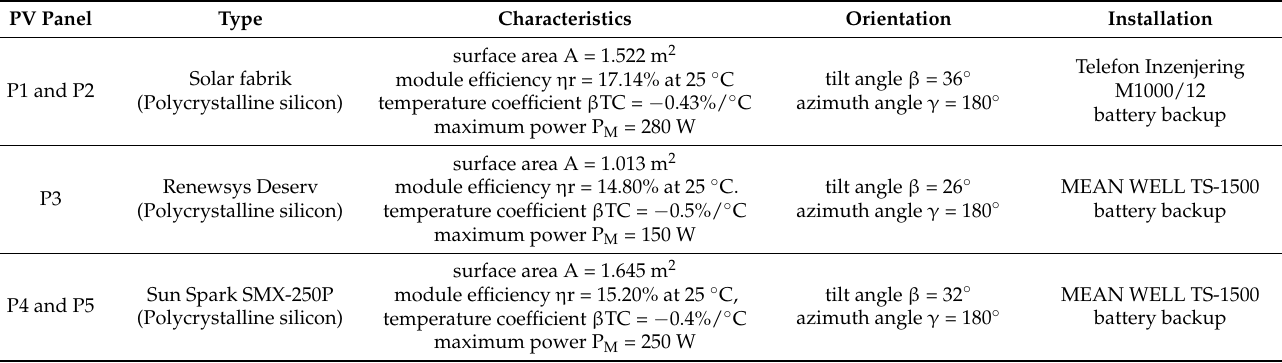
Table 2. The features of the used PV panels P1–P5.